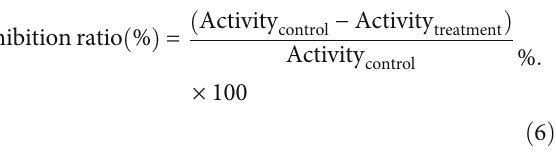
Table 2: Changes in the kinetic constants ( V Puri fi ed LAP Red